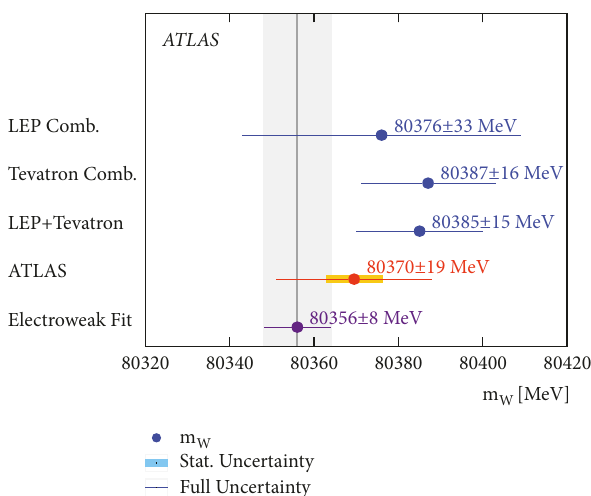
Figure 1: Overview of the measurements of the 𝑊 boson mass. The indirect determination via the electroweak fit sets the precision for the measurements via direct determinations. Figure from Ref.